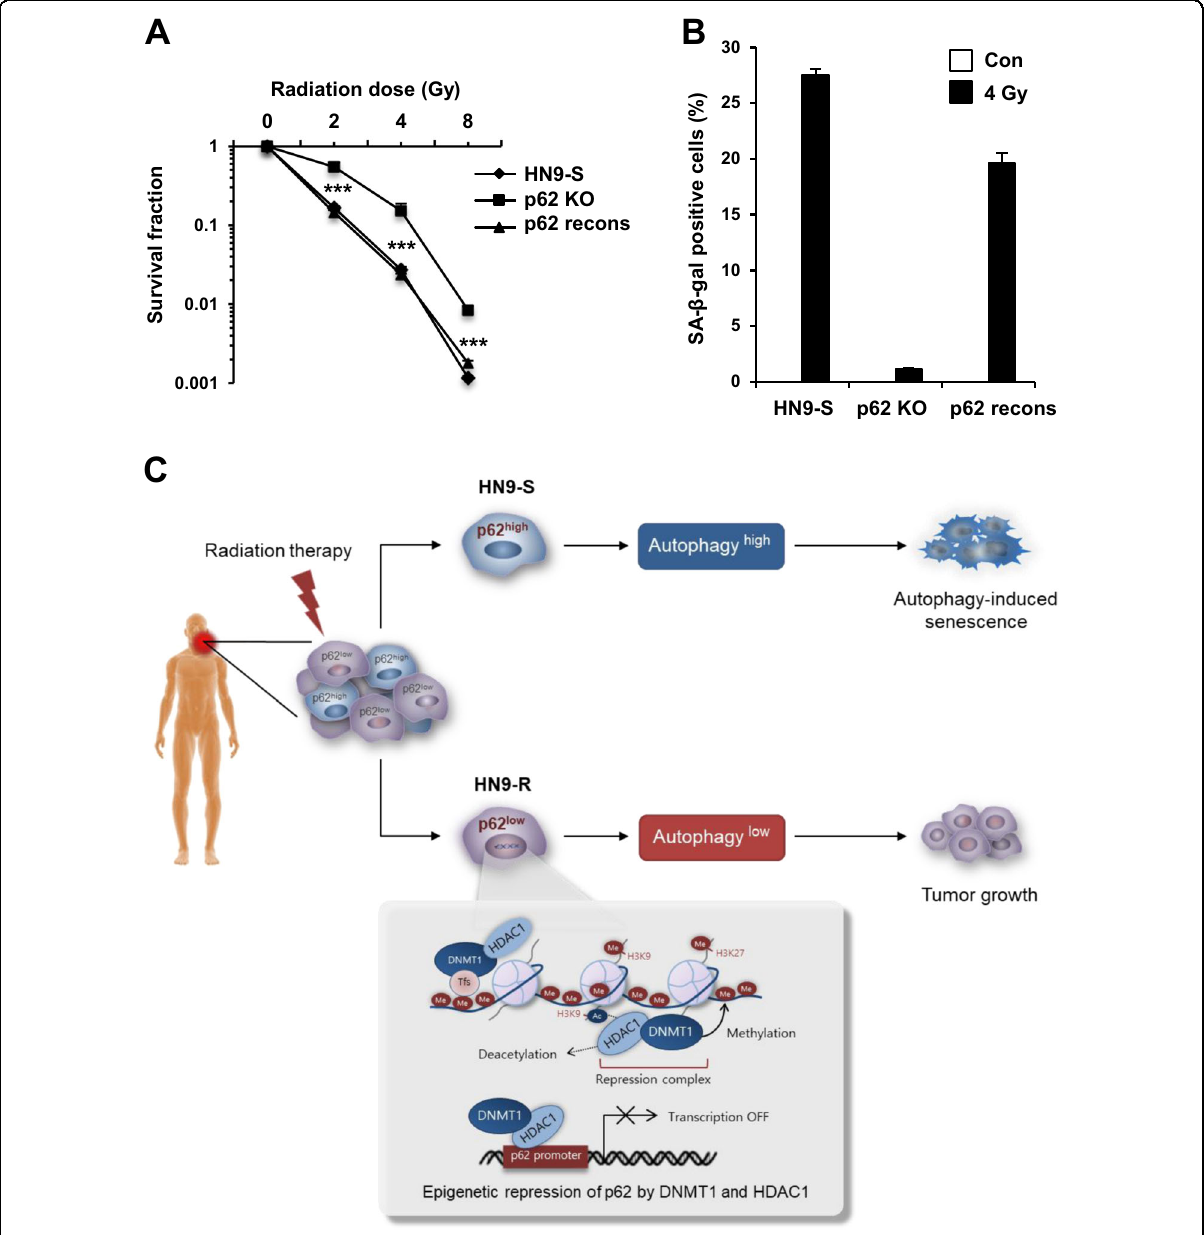
Fig. 7 Knock-out of p62 expression decreases a sensitivity to radiation and senescence induction in HN9-S clones. A , B HN9-S cells were totally ablated of endogenous p62 using the CRISPR/Cas9 system (p62 KO), after which a reversal construct of wild type p62 was transiently transfected to p62 KO cells (p62 recons). Clonogenic survival ( A ) and percentage of cells positive for SA- β -gal staining ( B ) in HN9-S and p62 gene- edited HN9-S cells after irradiation ( n = 3). Results are presented as means ± standard error of the mean (SEM). *** p < 0.005. C Overview of the different epigenetic regulation of p62 expression and the survival responses against irradiation in subclones, HN9-R and HN9-S, within a radio- resistant head and neck cancer